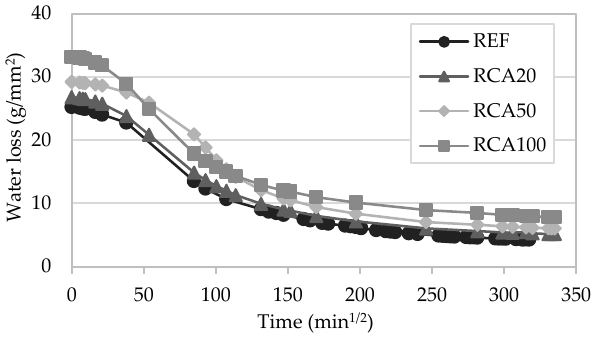
Figure 10. Drying curves of the RCA mortars.